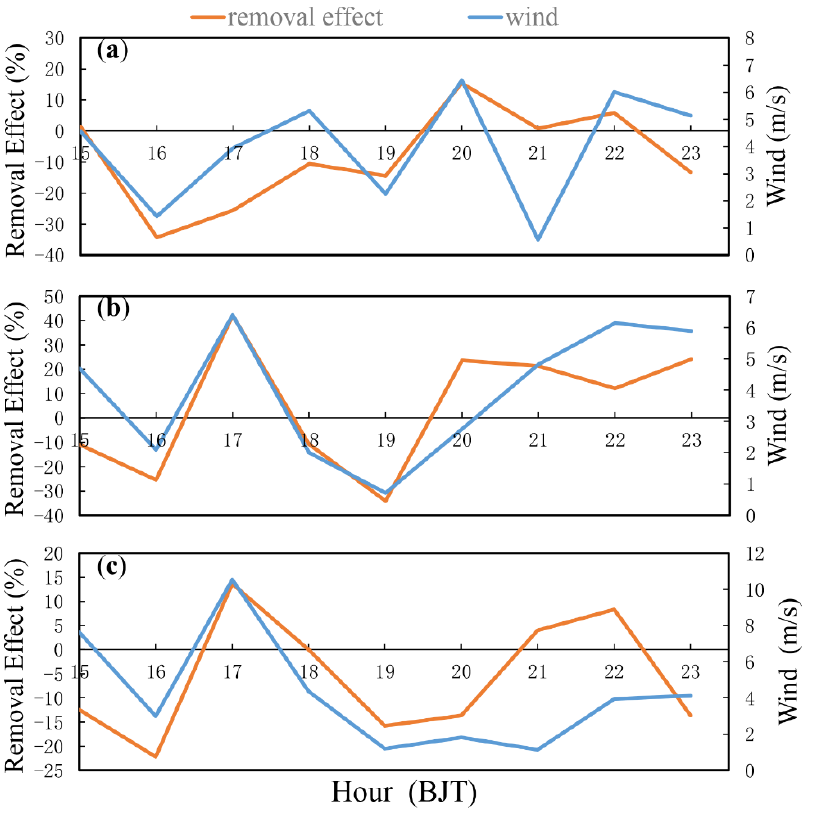
Figure 6. Hourly variation of removal effect of precipitation and wind speed at a height of 100 m above the ground for selected precipitation event cases at the site of Tangshan Ceramic Company (118.22° E, 39.67° N) in the BTH region at 17:00 on 12 March 2016 ( a ), at the site of the Zhenjiang Vocational Education Center (119.49° E, 32.22° N) in the YRD region at 16:00 on 26 June 2016 ( b ), and at the Nanyou Station in Shenzhen City (113.92° E, 22.52° N) in the PRD region at 16:00 on 5 September 2017 ( c ). “BJT” represents Beijing time.